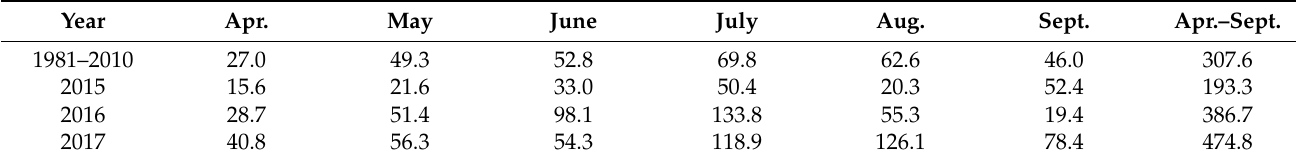
Table 2. Monthly totals of atmospheric precipitation in Mochełek in the years of research against the long-term averages